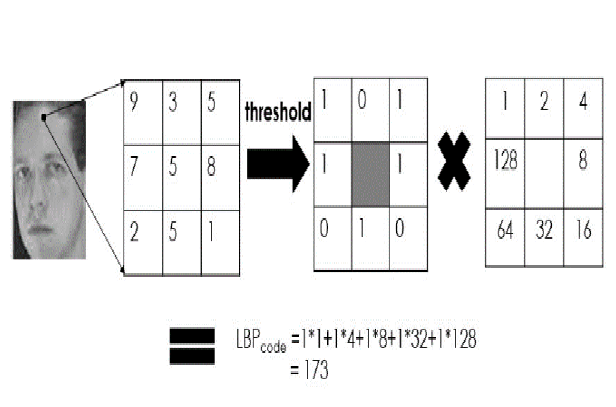
Figure 1. Illustration of the basic local binary patterns operator.